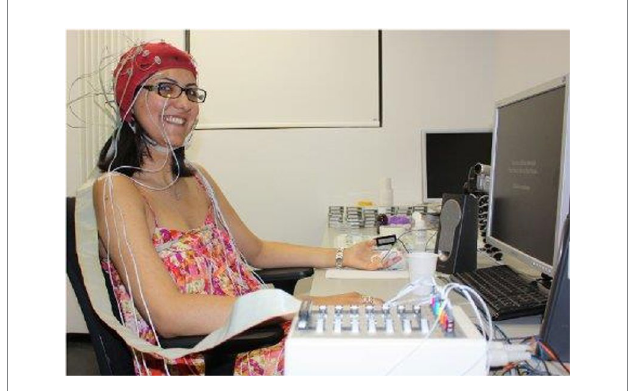
FIGURE 5 Collection scene for the Deap database (Koelstra et al., 2012). Reproduced with permission from IEEE. Licence ID: 1319273-1.